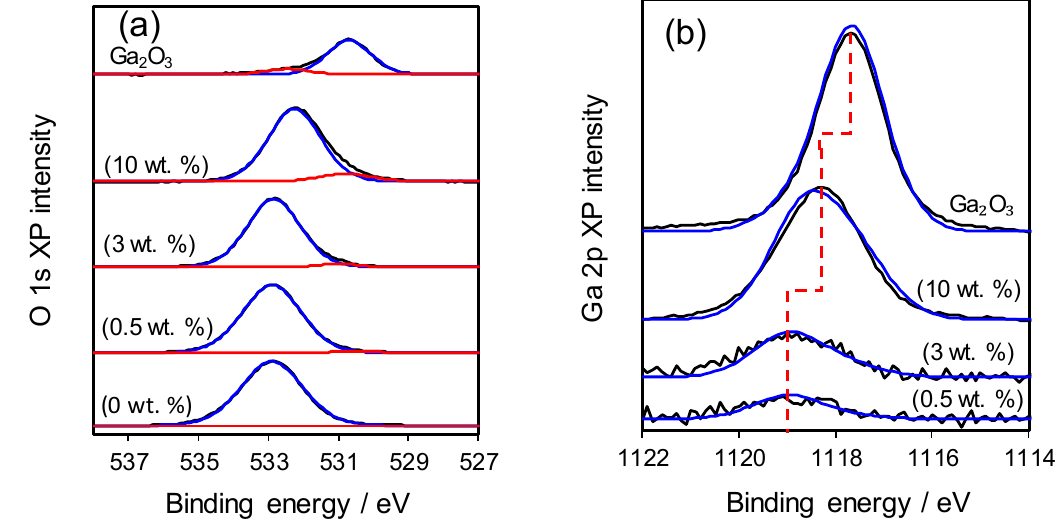
Figure 3. ( a ) O 1s and ( b ) Ga 2p XP spectra of xGa/HZSM-5 and Ga 2 O 3 .